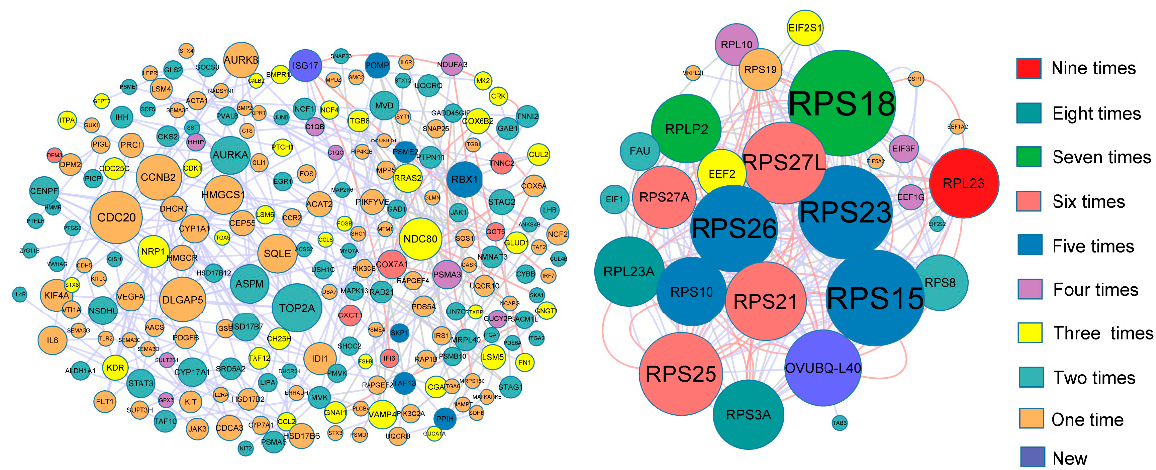
Figure 11. The interaction network of differential protein with three tissues. The size of shape indicates Degree. Different colors correspond to the number of participating stages.